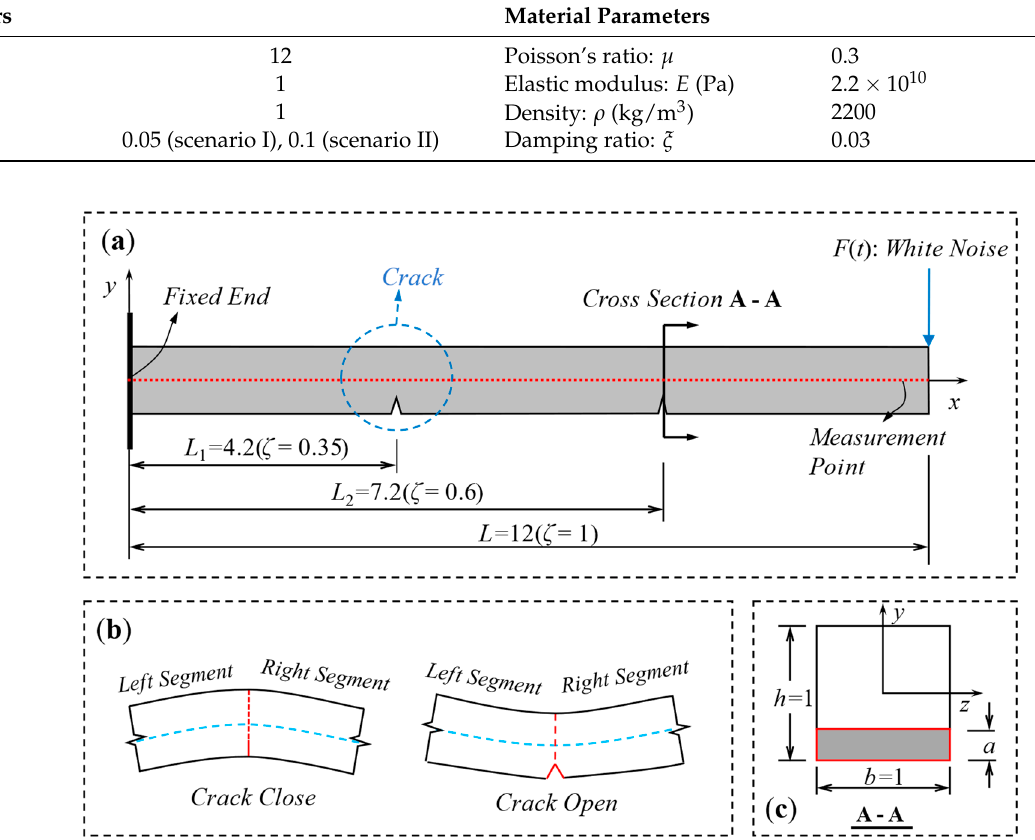
Figure 5. Model diagram of cracked cantilever beam: ( a ) schematic diagram; ( b ) crack state; ( c ) cross section.